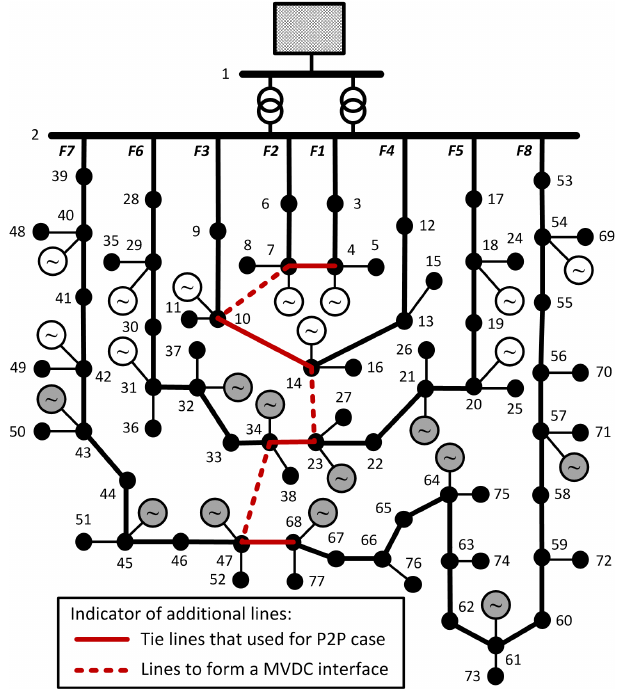
Figure 6. The modified hybrid AC/DC UK generic distribution system.